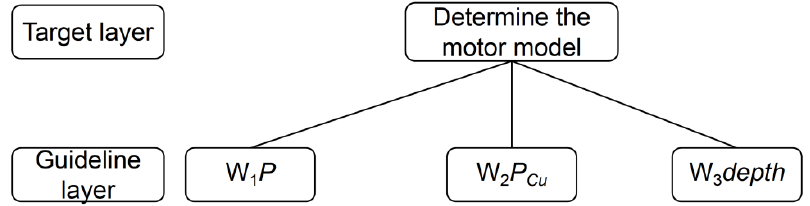
11 of 19 Table 5. The results of multi-parameter step-by-step optimizations. Parameters